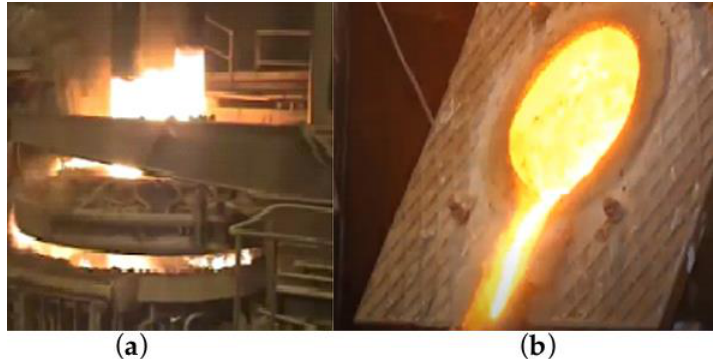
Figure 1. Melting furnaces: ( a ) electric arc furnace; ( b ) crucible induction furnace. As practice has shown, dinas acquires the best properties, in which the main amount of quartz is converted into tridymite, which ensures its fire resistance at 1680 – 1730 °C.